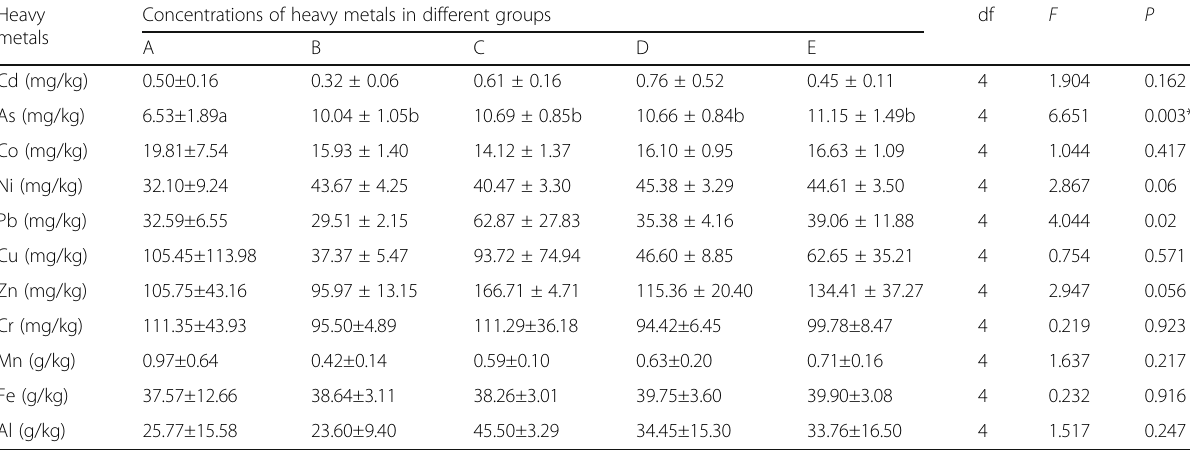
Table 4 Descriptive statistical analysis of 11 heavy metals in sediment samples of lakes along a rural to urban gradient in central China